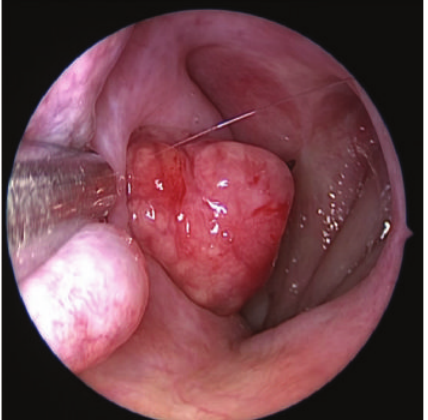
Figure 4: Recurrent tumor shown at the time of his second endo- nasal